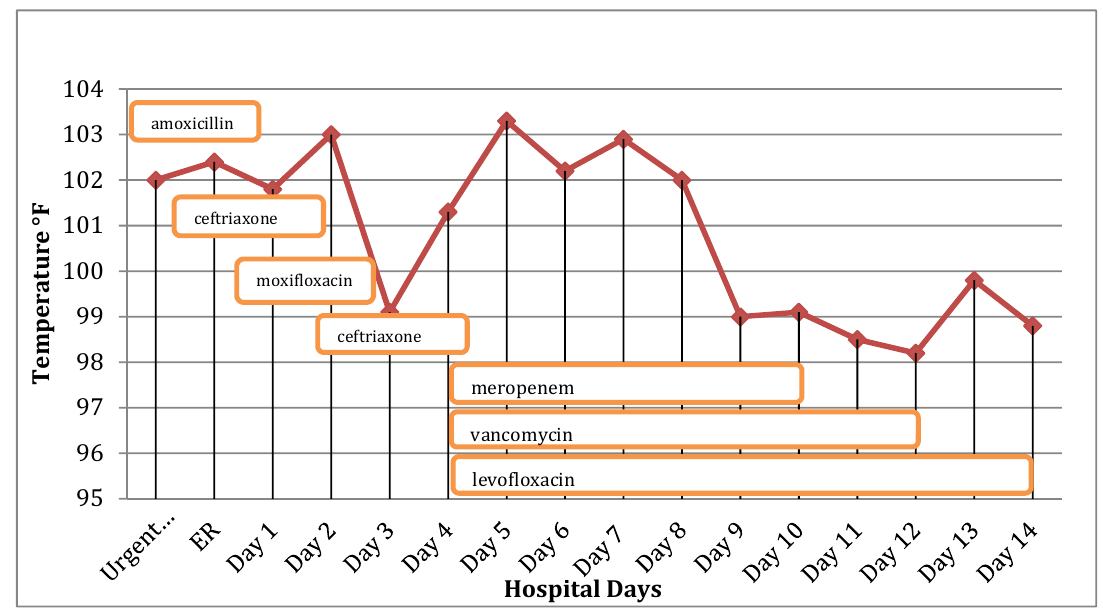
Figure 1. Temperature ( ◦ F) and antibiotics prescribed over